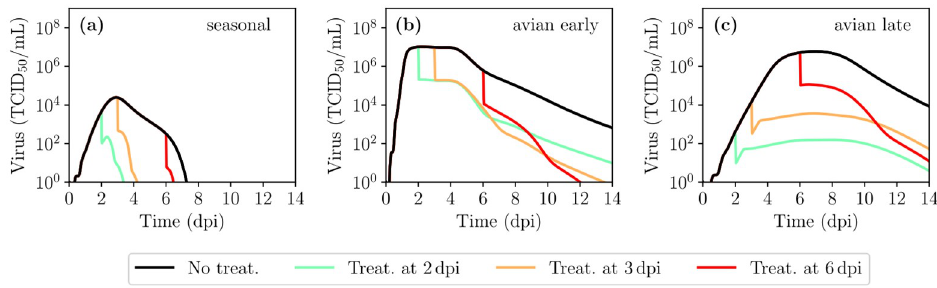
Fig 12. MM-predicted NAI antiviral therapy efficacy in patients infected with a seasonal or avian IAV strain. The viral titer time course for IAV infections under antiviral therapy initiated at various times post infection (see legend) with NAIs, captured as decreasing virus production rate. The effect of treatment is shown in the context of infection with (a) a seasonal IAV strain; or with an avian IAV strain based on either the (b) early or (c) late infection portraits. The drug efficacy, ε , was chosen to be 0.98. The other parameters used in the MM are those listed in Table 2.